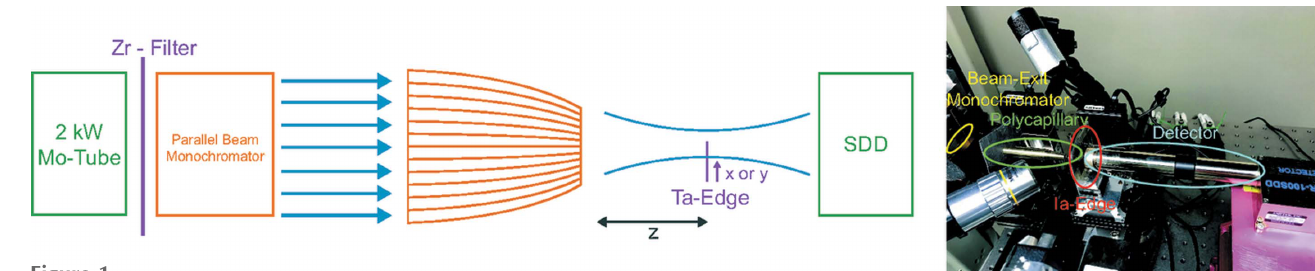
Figure 1 Experimental laboratory setup at the Atominstitut of TU